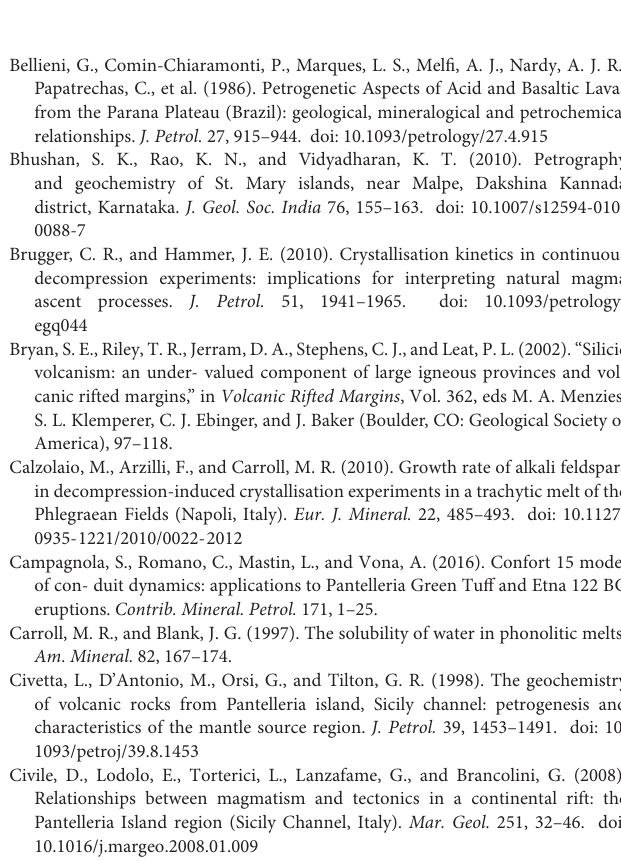
TABLE S2 | Chemical compositions of alkali